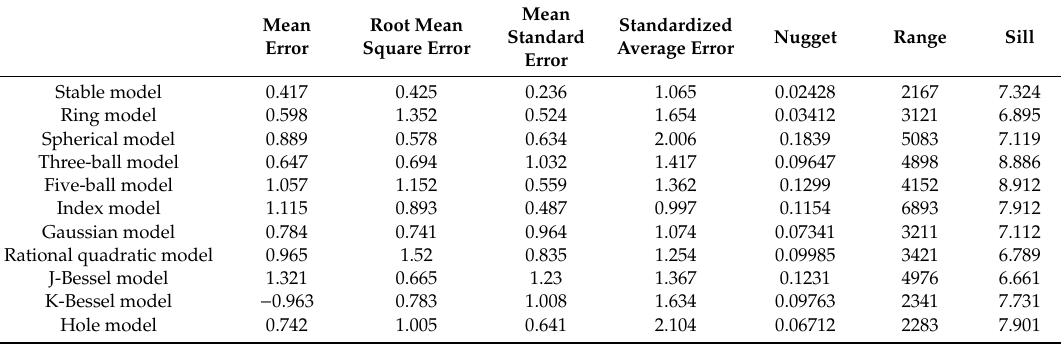
Table 2. Interpolation accuracy evaluation of di ff erent semivariogram